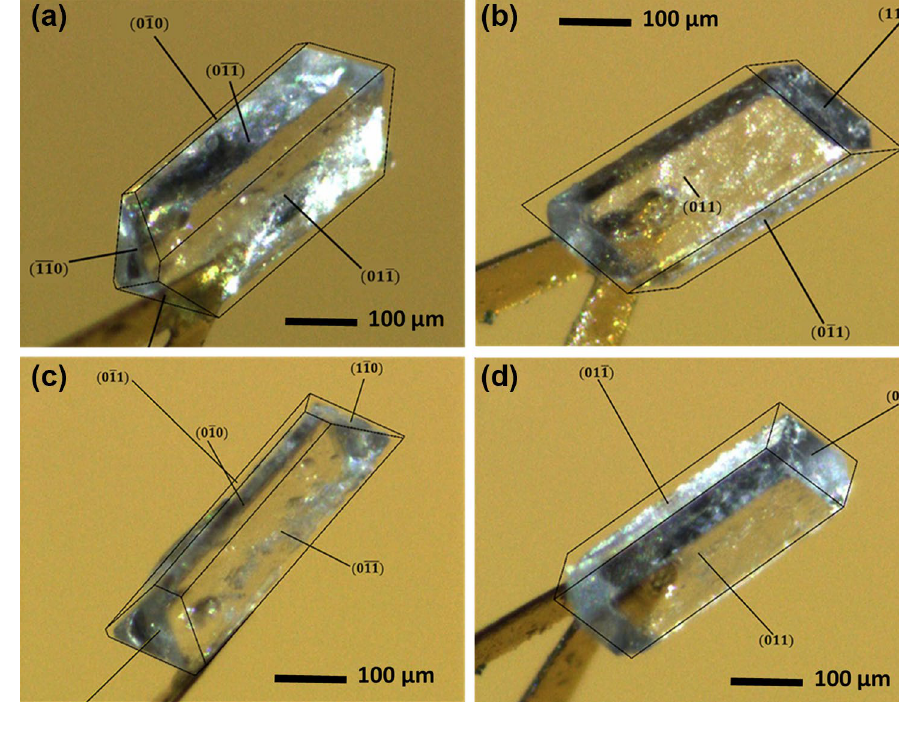
Fig. 1 Identified faces of β-HMX crystals for two mor- phologies: a , c morphology 1 and b , d morphology 2